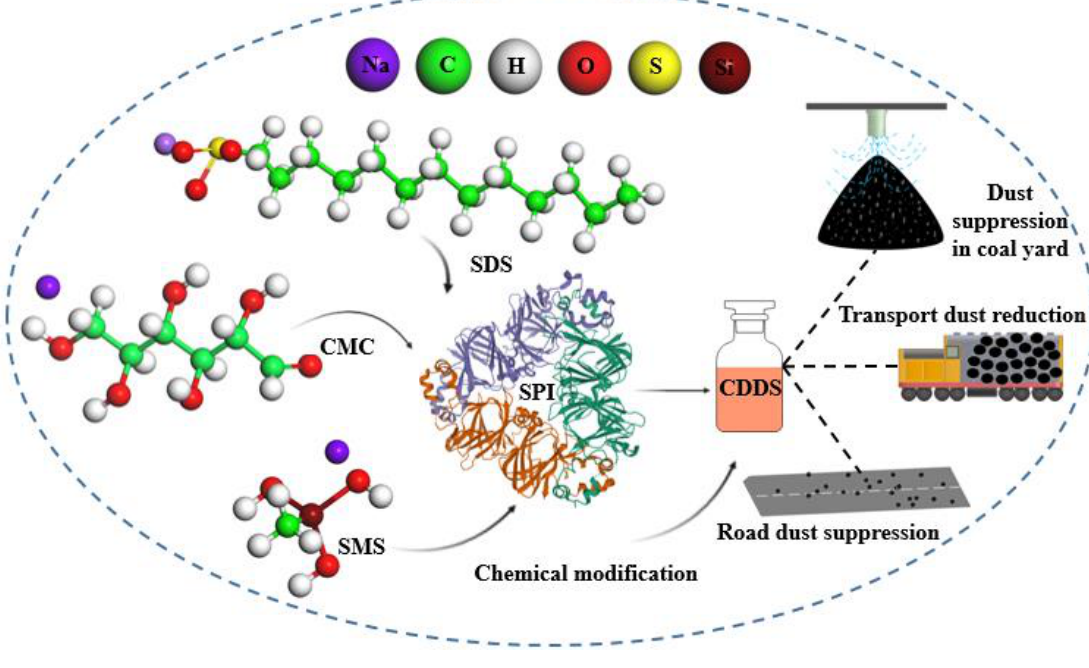
Figure 2. Schematic diagram of dust suppressor preparation.